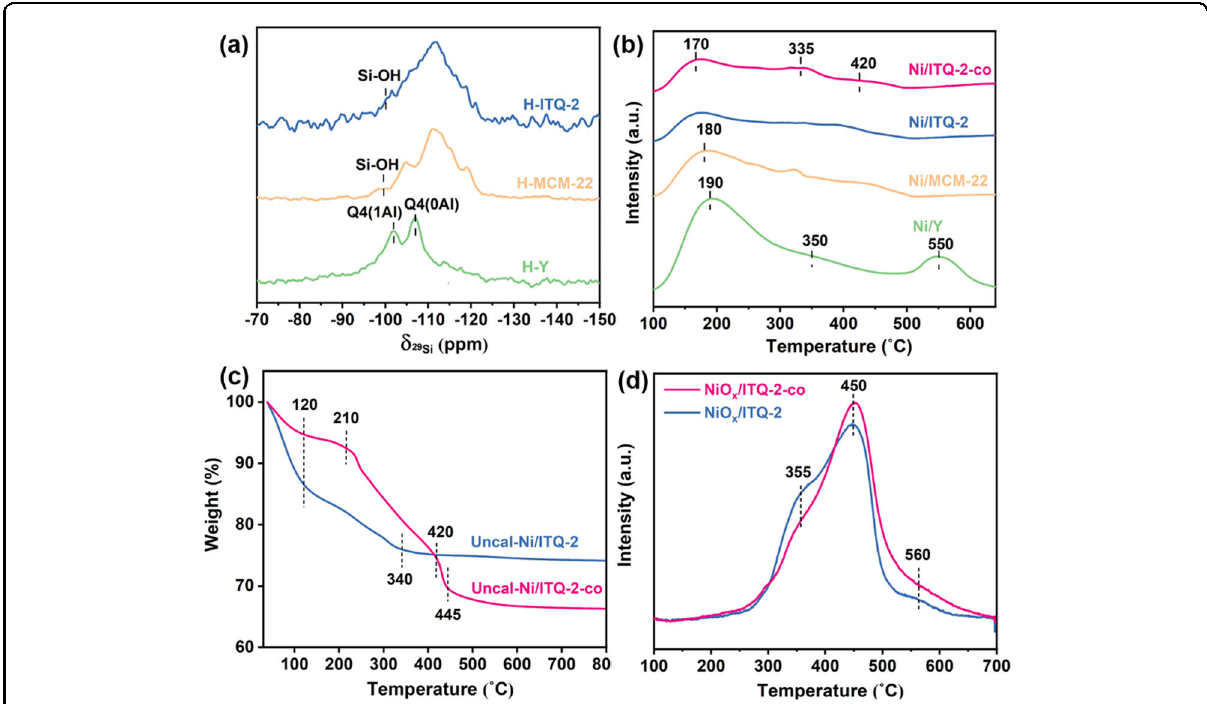
Fig. 2 Framework environment of supports and evolution of Ni species during activation process. a 29 Si NMR spectra of the prepared zeolite supports. b NH 3 -TPD pro fi les of the prepared Ni/zeolite samples; c TG analyses of the uncalcined Ni/ITQ-2 and Ni/ITQ-2-co samples; d H 2 -TPR pro fi les of the NiO x /ITQ-2 and NiO x /ITQ-2-co materials that were calcined before